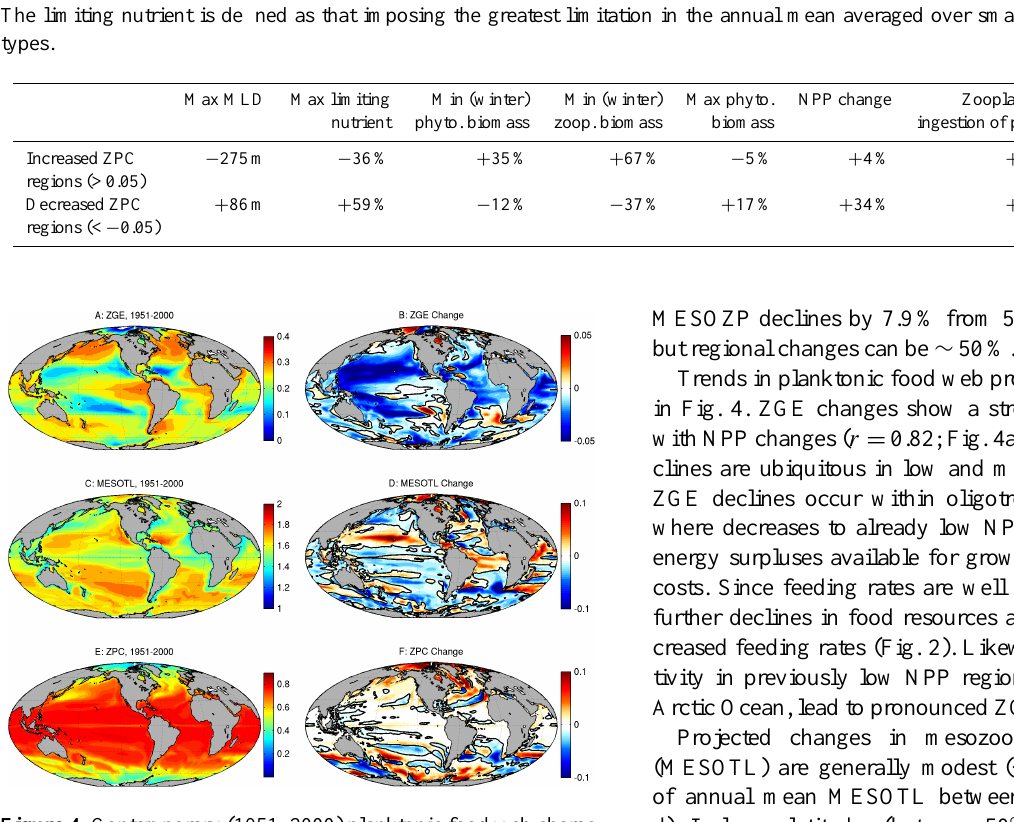
Figure 4. Contemporary (1951–2000) planktonic food web charac- teristics (ZGE, MESOTL, and ZPC) and changes in these proper- ties: (2051–2100)–(1951–2000). The 0 contour is